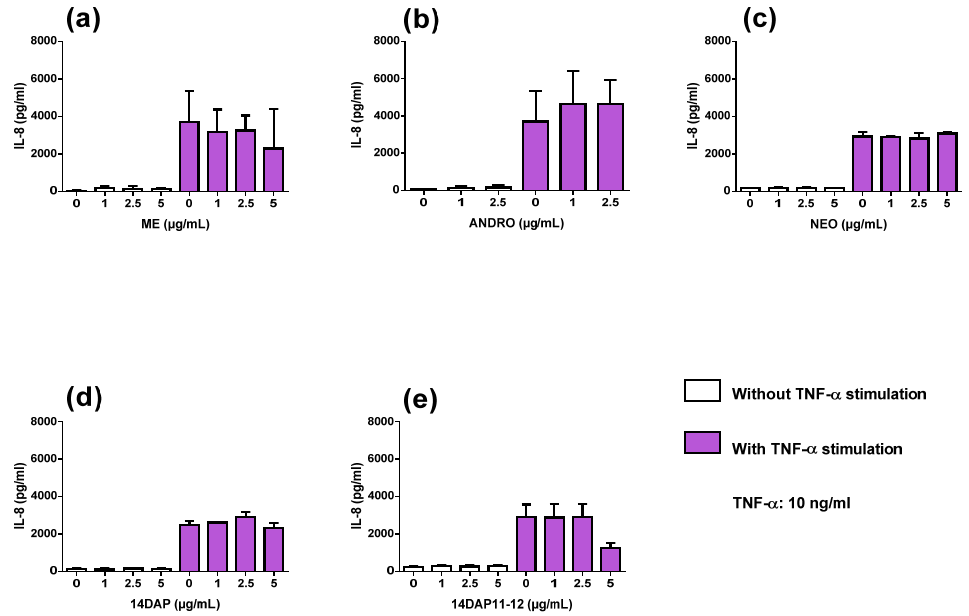
Figure 5. IL-8 secretion and e ff ect of ME, ANDRO, NEO, 14DAP, and 14DAP11-12 in HaCaT under Figure 5. IL ‐ 8 secretion and effect of ME, ANDRO, NEO, 14DAP, and 14DAP11 ‐ 12 in HaCaT under pro-inflammation conditions. ME ( a ), ANDRO ( b ), NEO ( c ), 14DAP ( d ), or 14DAP11-12 ( e ) was used at pro ‐ inflammation conditions. ME (a), ANDRO (b), NEO (c), 14DAP (d), or 14DAP11 ‐ 12 (e) was used 1, 2.5, or 5 µ g / mL for 24 h. The control cells were treated with 0.05% DMSO (noted as “0”). Inflammation at 1, 2.5, or 5 μ g/mL for 24 h. The control cells were treated with 0.05% DMSO (noted as “0”). was induced by TNF- α (10 ng / mL) and IL-8 secretion was performed using an ELISA assay. The values Inflammation was induced by TNF ‐α (10 ng/mL) and IL ‐ 8 secretion was performed using an ELISA are mean ± SD, compared with control group, n = 3. Abbreviations: IL-8, assay. The values are mean ± SD, * p < 0.05 compared with control group, n = 3. Abbreviations: IL ‐ 8, interleukin ‐ 8.